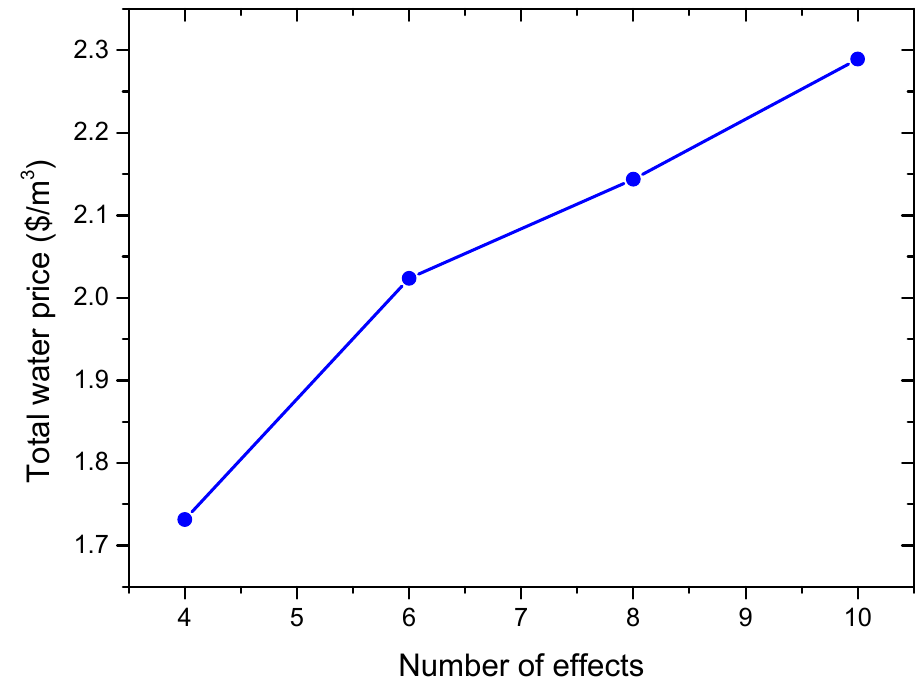
Figure 7. Influence of the number of effects on the TWP.